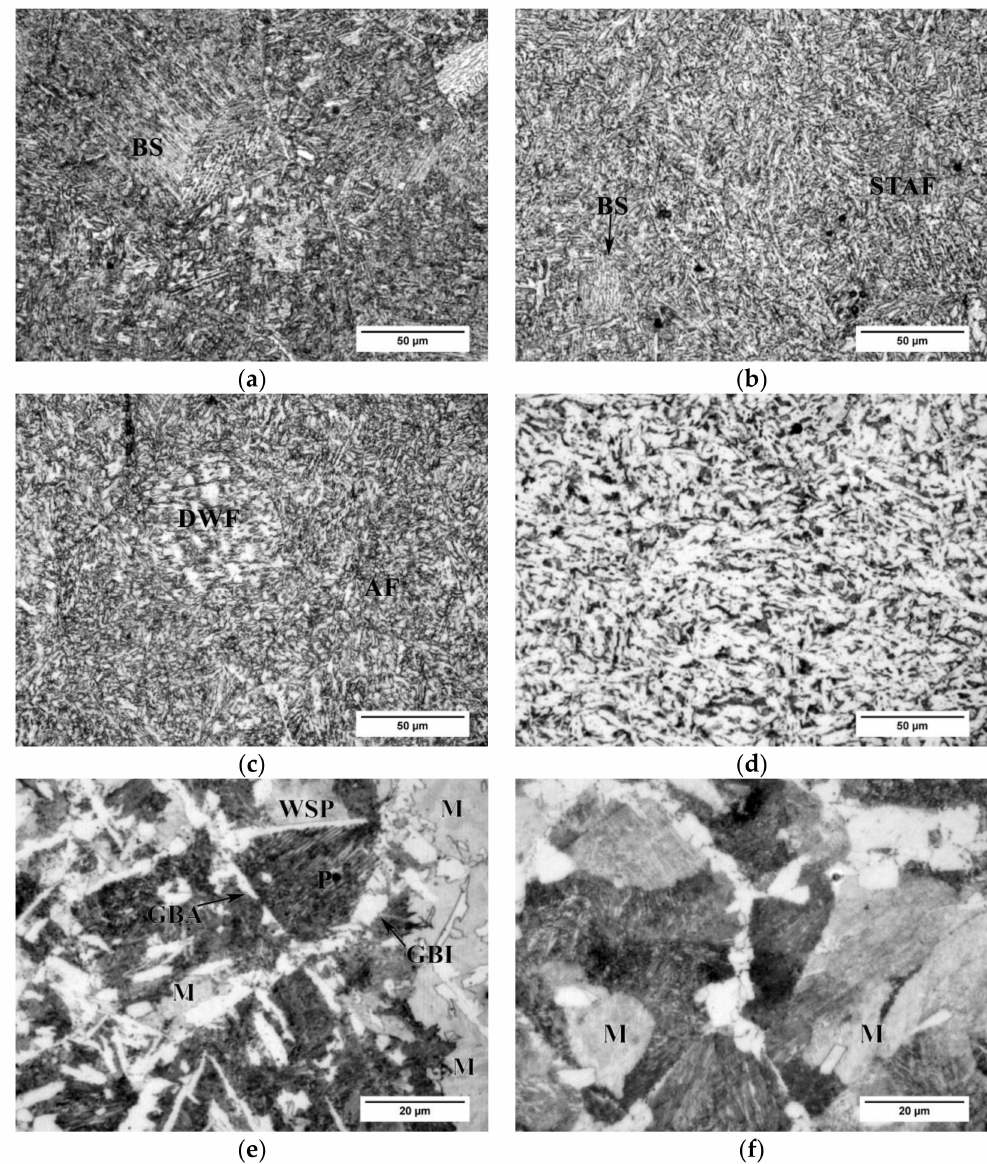
Figure 2. Microstructures of Ti-V steel after 1200 s of isothermal transformation at: ( a ) 350 ◦ C, ( b ) 400 ◦ C, ( c ) 450 ◦ C, ( d ) 500 ◦ C, ( e ) 550 ◦ C, ( f ) 600 ◦